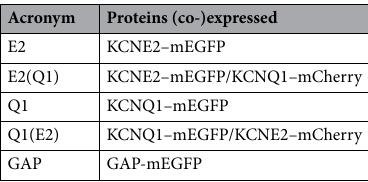
Table 1. Summary of the experiment conditions and related terminology used throughout the paper.